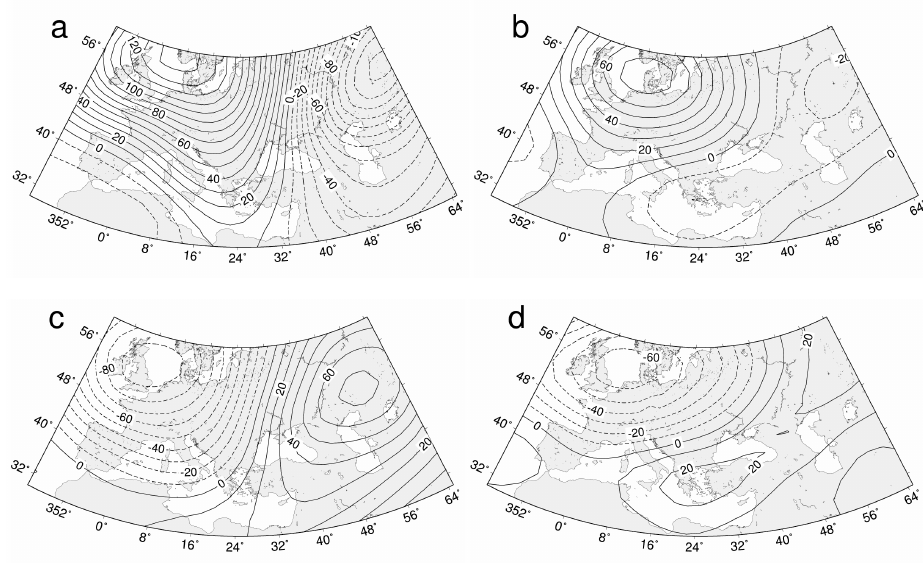
Fig. 2. Same as Fig. 1, but for mean geopotential heights departures. were used for the period 1948–2007 converted into monthly